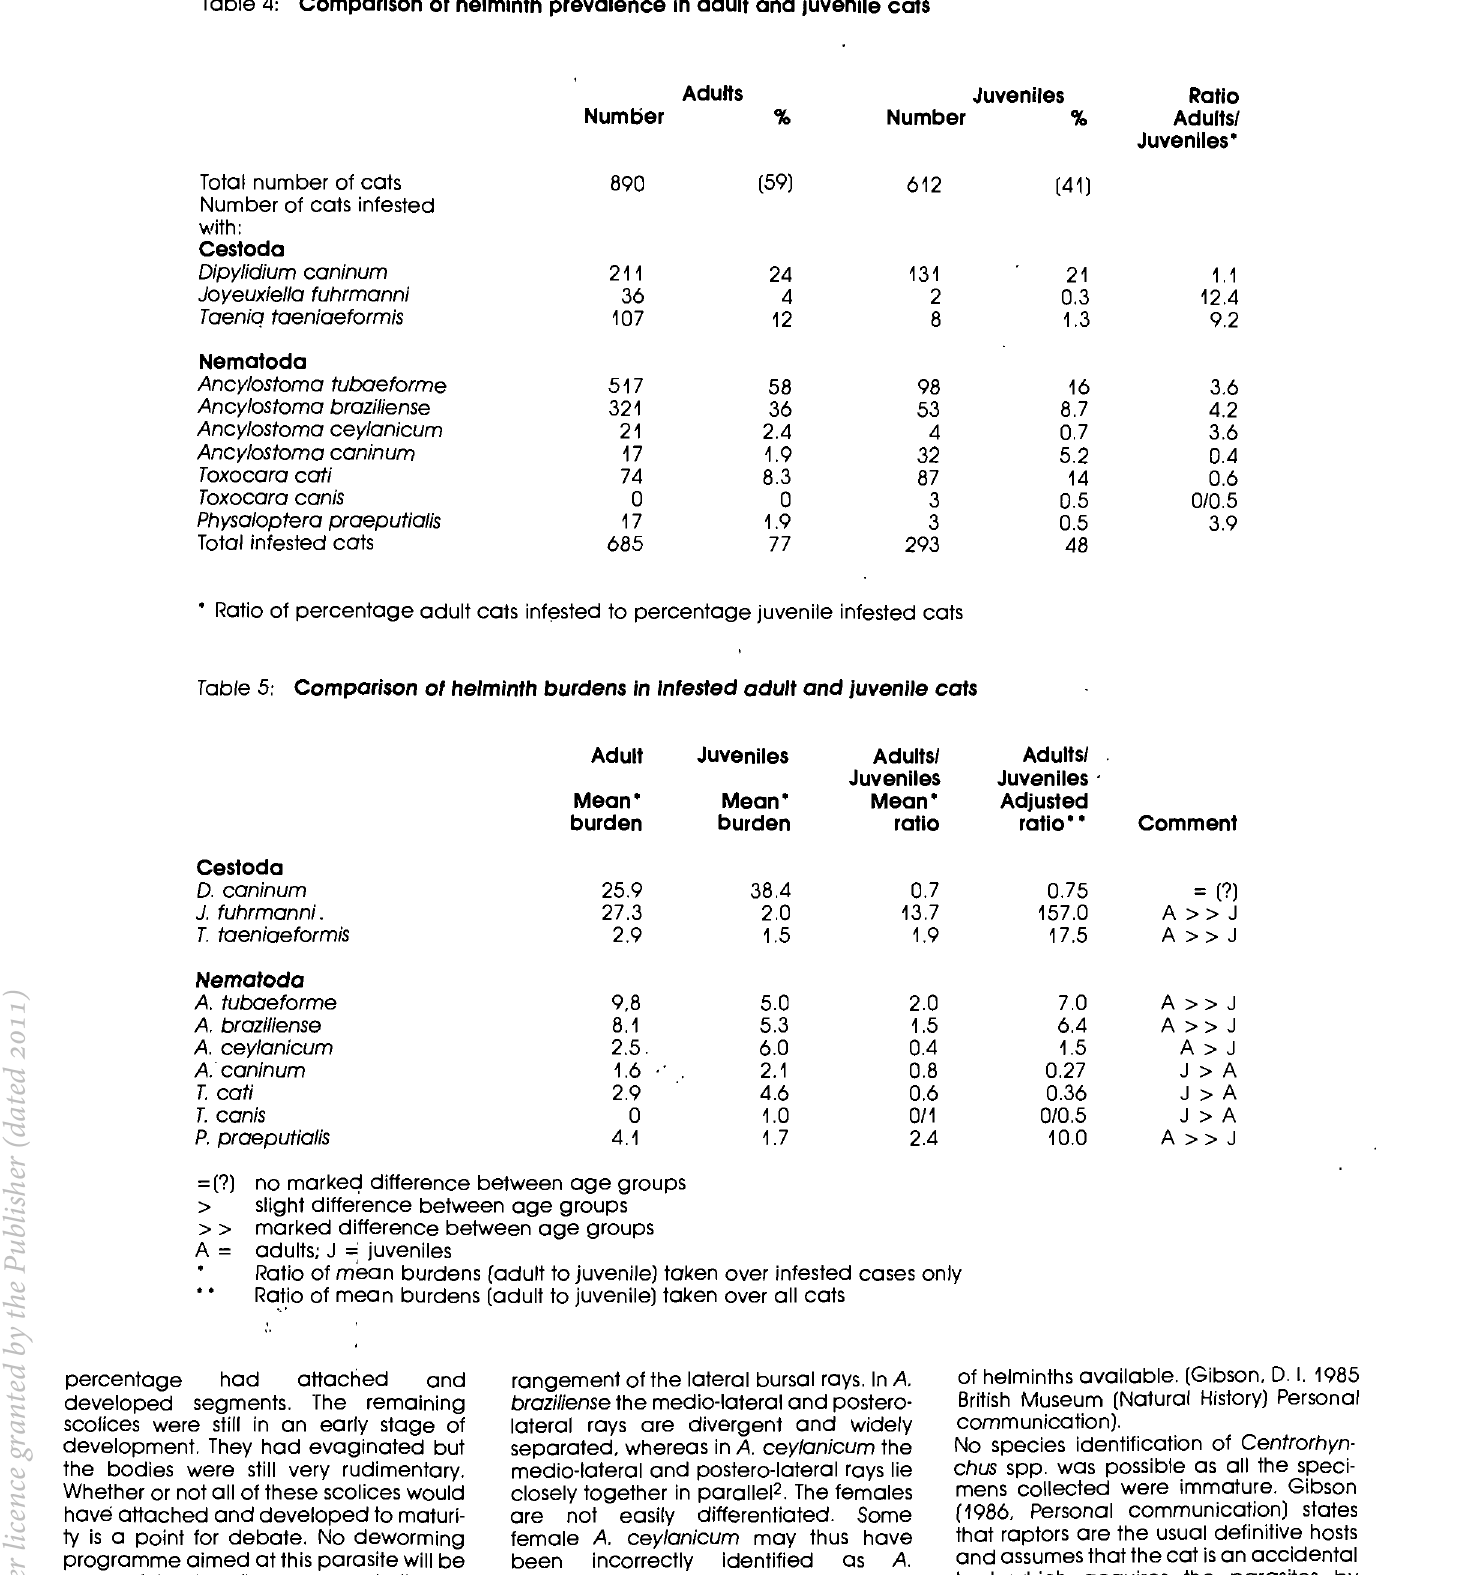
Table 4: Comparison of helminth prevalence In adult and juvenile cats